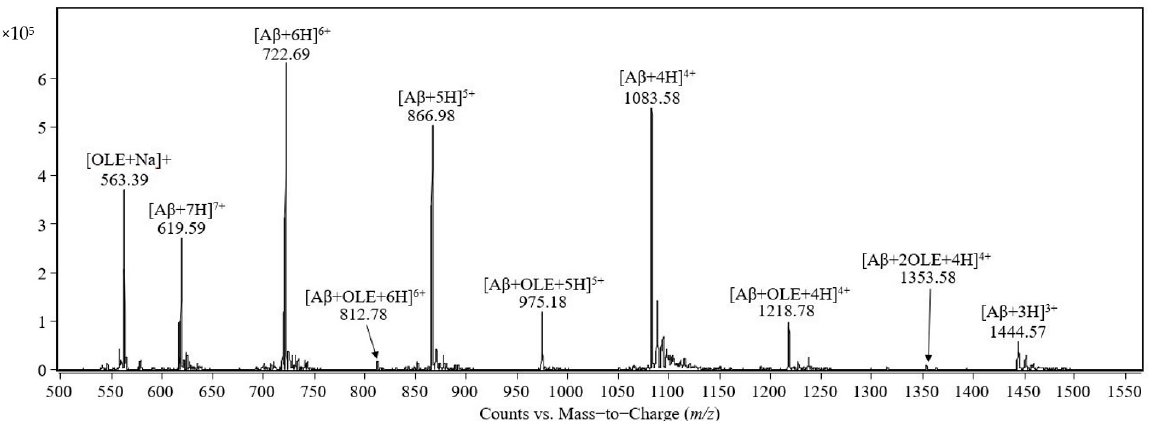
Figure 1. Mass spectrum of the 1:1 complex formed between A β (1–40) and oleuropein both at 50 pmol/ µ L in a final solution of 0.5 mM ammonium acetate and 0.25% acetic acid, pH 3, recorded 30 min after incubation on the electrospray-triple quadrupole mass spectrometer.